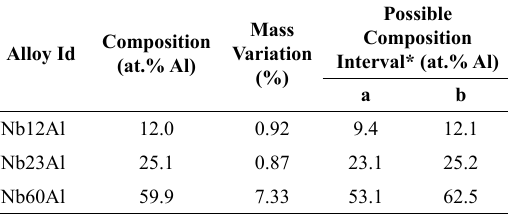
Table 4. Compositions of the Nb-Al alloys prepared in this work, after